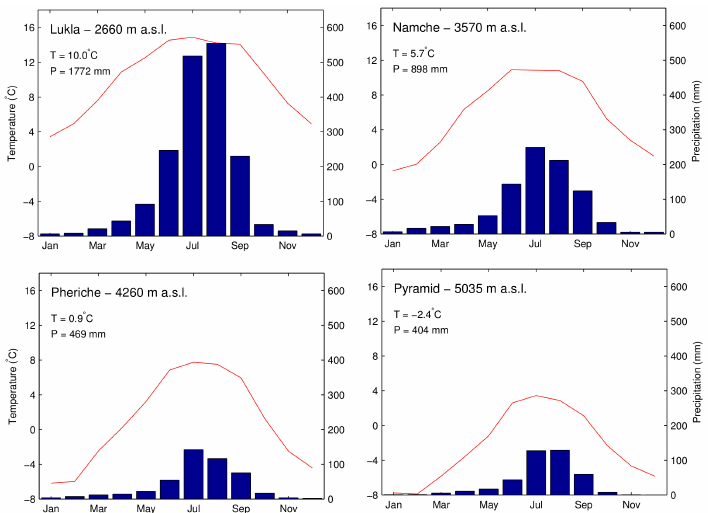
Fig. 4. Mean annual cycle of monthly precipitation ( P , histograms) and monthly air temperature ( T , red line) during 2003–2012 at four meteorological stations operated by Ev-K2-CNR: Lukla (2660ma.s.l.), Namche Bazar (3570ma.s.l.), Pheriche (4260ma.s.l.) and Pyramid (5035ma.s.l.). T and P are the mean annual temperature and the cumulative annual precipitation respectively. The data gaps for Lukla